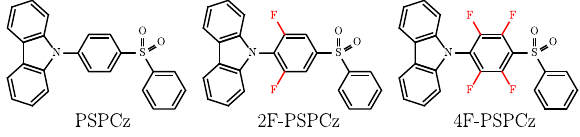
Fig. 1 Molecular structures of the PSPCz molecules. 9-[4-(phenyl- sulfonyl)-phenyl] 9H-carbazole (PSPCz), 9-[4-(phenylsulfonyl)-2,6- di fl ourophenyl] 9H-carbazole (2F-PSPCz), and 9-[4-(phenylsulfonyl)- 2,3,5,6-tetra fl uorophenyl] 9H-carbazole(4F-PSPCz).